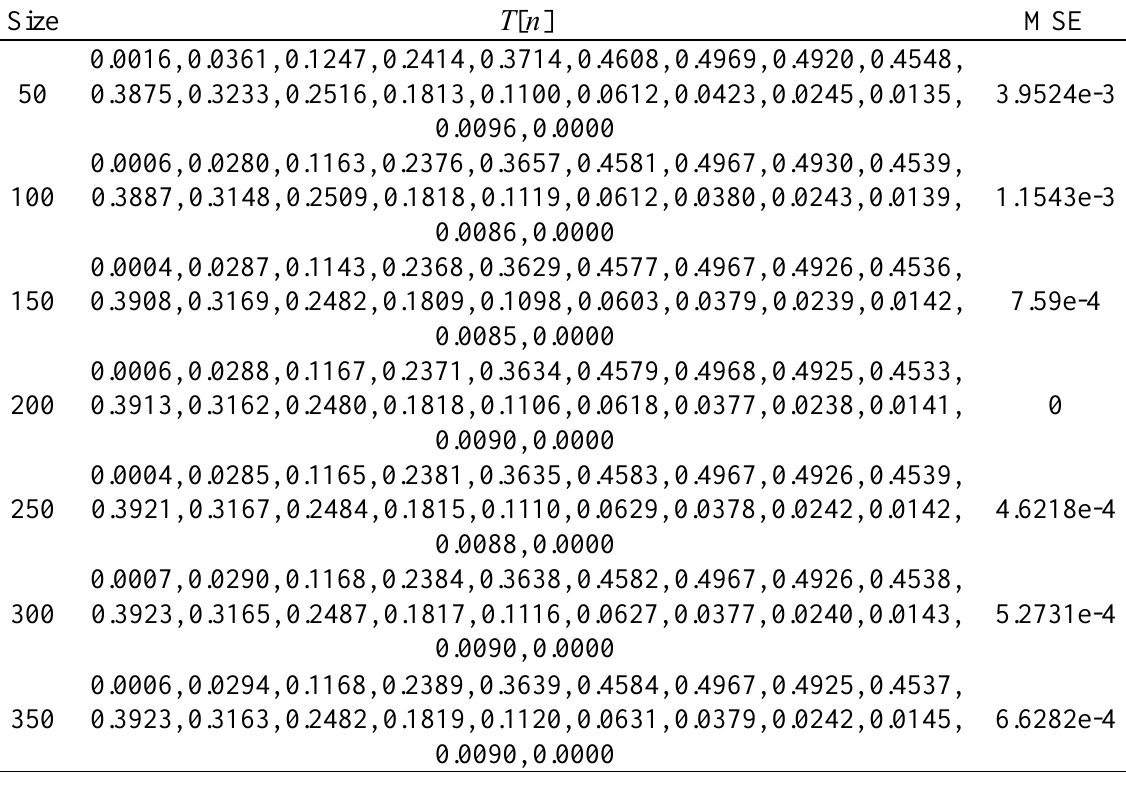
Table 1. The impact of scaling (Size of the origin image is 200 pixels).